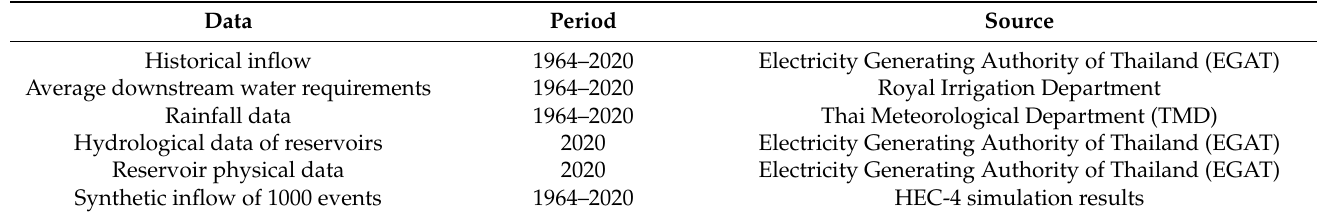
Table 1. The database layer for searching the optimal rule curves for network reservoir.